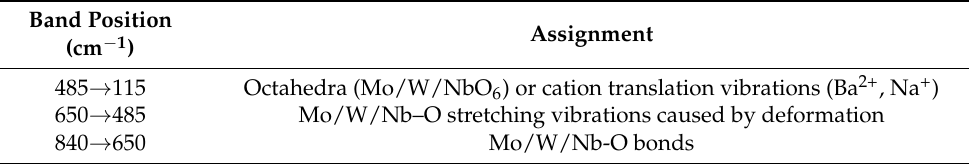
Figure 3. Raman spectra of the Ba 0.54 Na 0.46 Nb 1.29 W (0.37 − x) Mo x O 5 (x = 0, 0.04, 0.08, 0.33) ceramics. Table 4. The Raman bands in the range of 1200–100 cm − 1 were identified for the Ba 0.54 Na